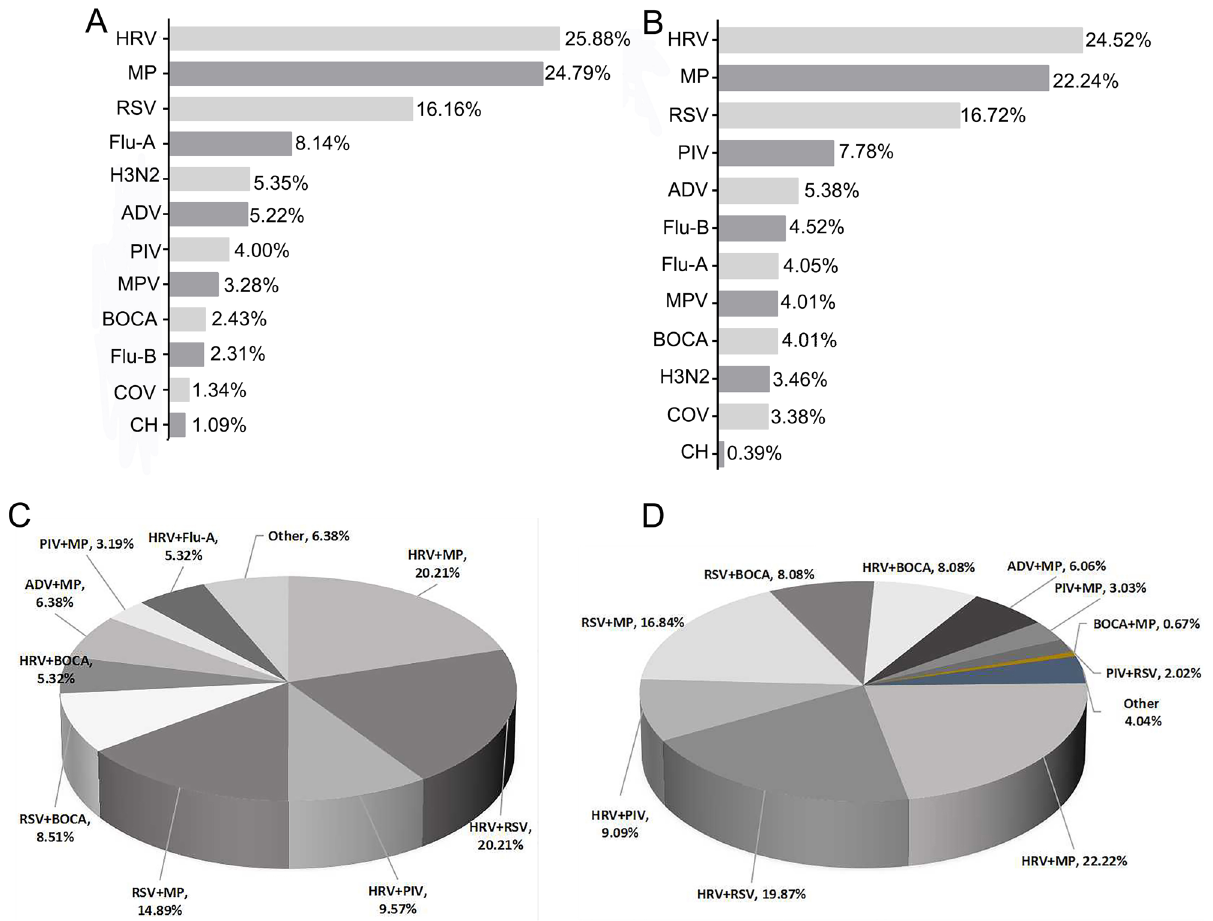
Figure 1. Detection of respiratory pathogens infection before and after the COVID-19 pandemic. ( A ) The overall positive rates of pathogens in 2019. ( B ) The overall positive rates of pathogens in 2020 and 2021. ( C ) The co-infection rate among patients in 2019. ( D ) The co-infection rate of pathogens in 2020 and 2021. HRV human Rhinovirus, MP mycoplasma pneumoniae, RSV respiratory syncytial virus, Flu-A influenza A virus, Flu-B influenza B virus, H3N2 influenza A virus H3N2, PIV parainfluenza virus, ADV adenovirus, Boca Boca virus, MPV Metapneumovirus, HCOV Coronavirus, Ch